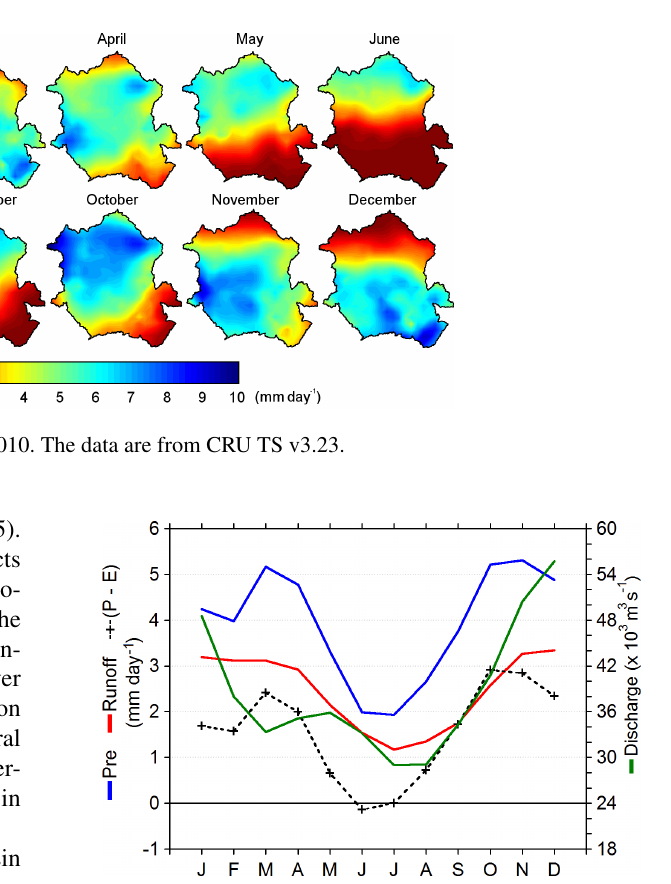
Figure 3. Annual cycle of precipitation, runoff, and ( P − E ) in the CRB (left axis) and the Congo River’s discharge (right axis). The data are from CRU, ERA-Interim, GLEAM, and the Global Runoff Data Center,